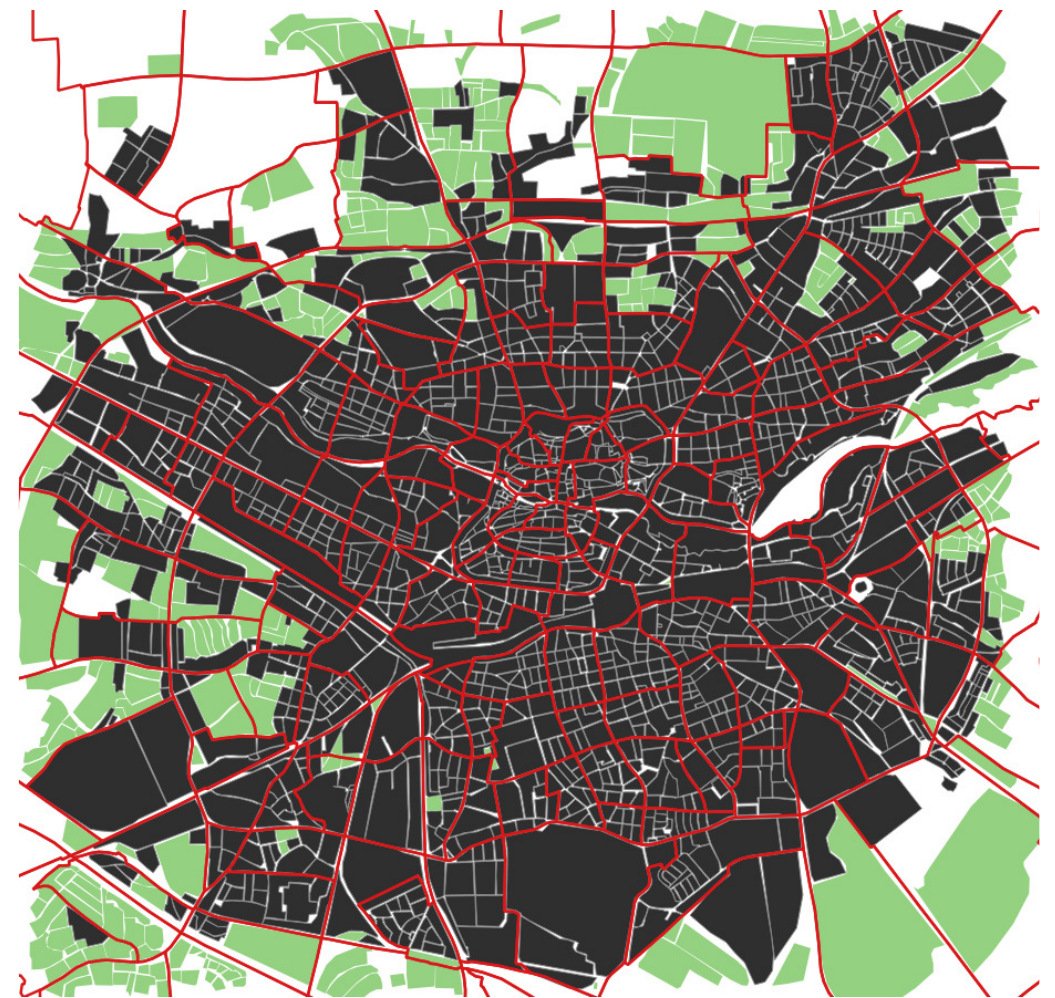
Figure 7. Digitized blocks existing historically (in black) and newly created blocks (in green) with district boundaries super‐ imposed (in red) for the central area of